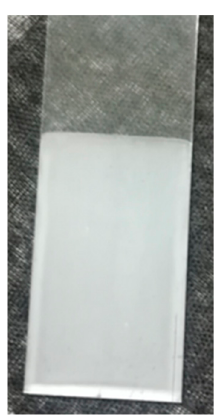
Figure 7. Representative appearance image of the coating aged for 5 days, obtained using a dipping velocity of 1000 mm/min.